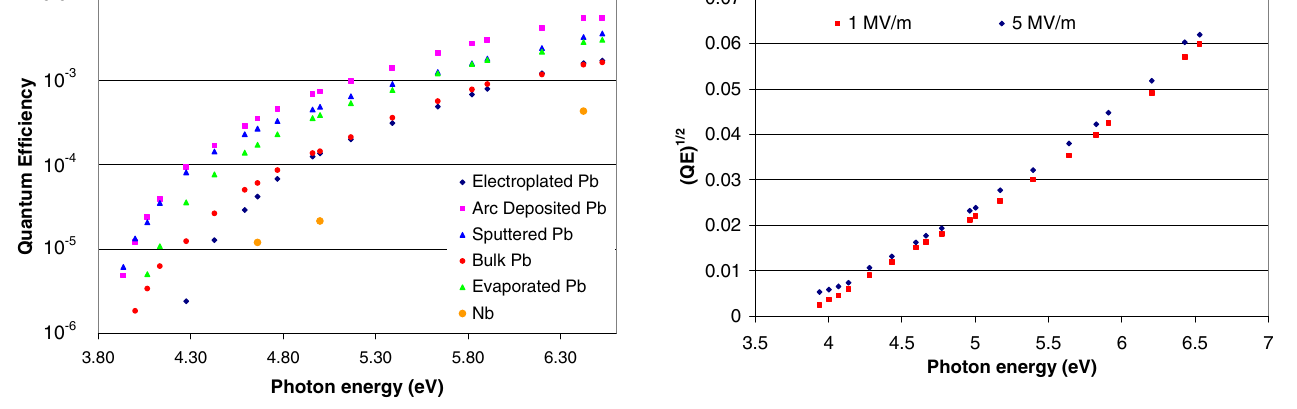
FIG. 9. (Color) Quantum efficiencies of various laser cleaned lead cathodes for photon energies between 3.9 and 6.5 eV.